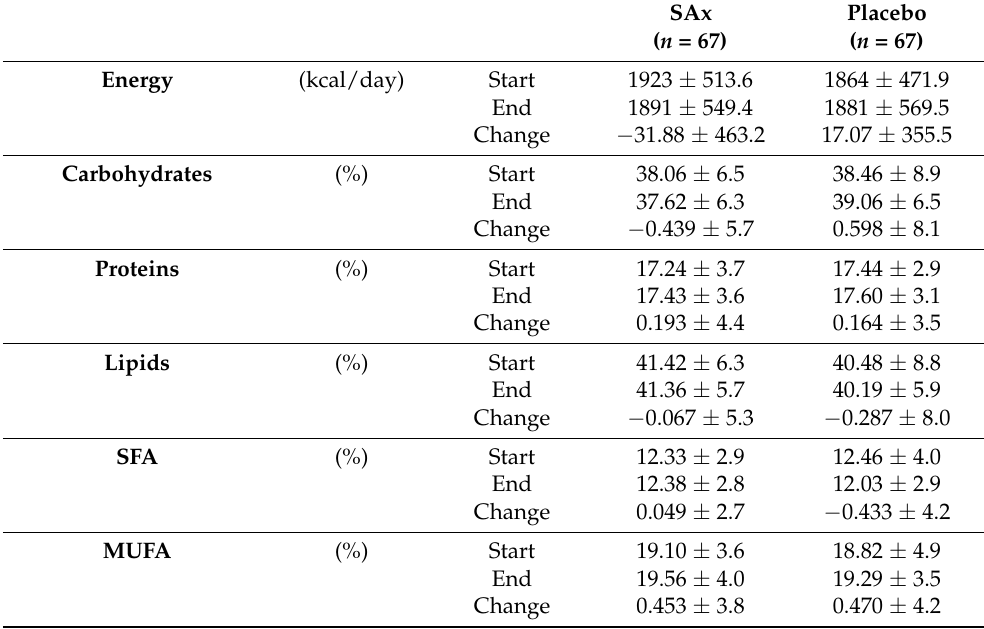
Table 2. The dietary and anthropometric variables at the beginning and end of the supplementation, and placebo